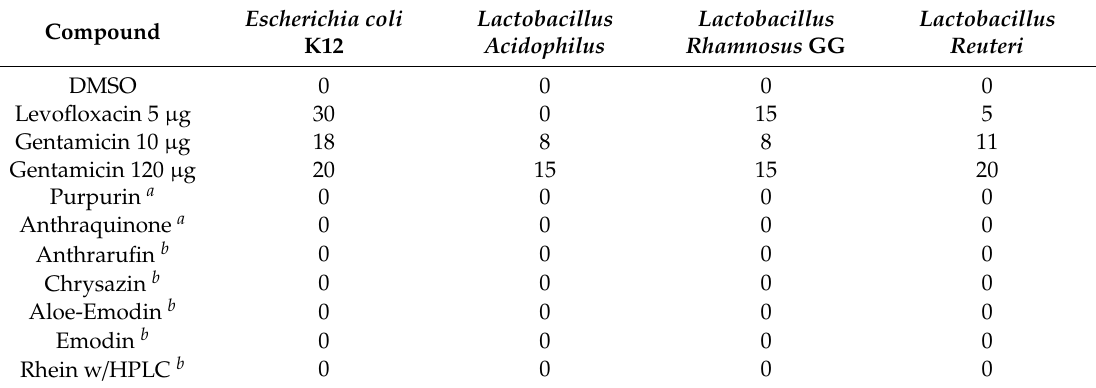
Table 3. Table depicts the zones of inhibition in mm (growth inhibition) from a disc di ff usion assay targeted against bacterial commensals using DMSO vehicle control, antibiotic controls, and test compounds at indicated concentrations a,b . a at 100 µ M, b at 10 µ